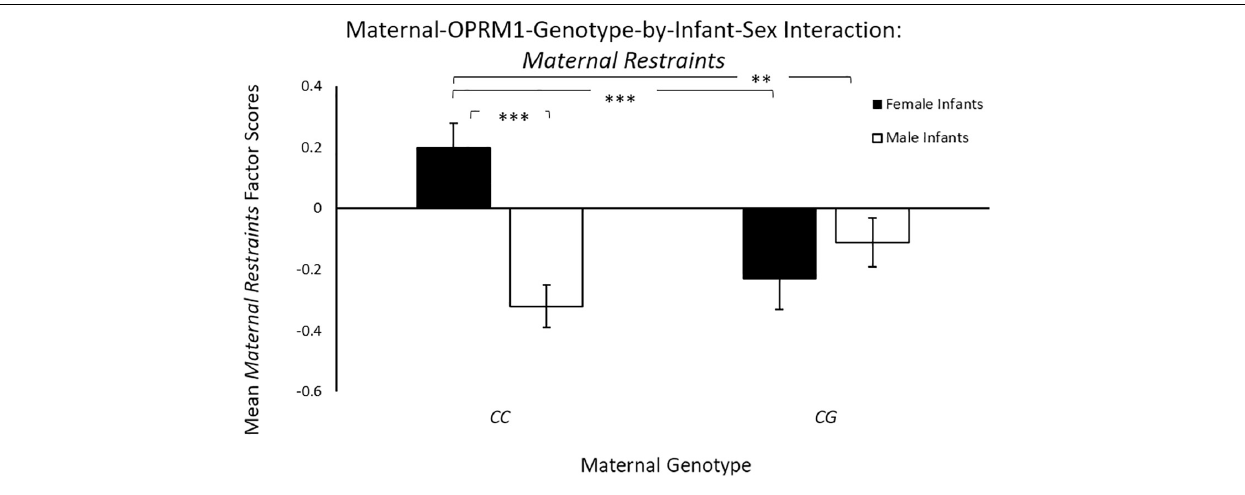
FIGURE 2 | Results showed a significant two-way sex-by-maternal-genotype interaction for Maternal Restraints (p = 0.001), with CC mothers with daughters exhibiting higher Maternal Restraint scores on average, when compared to CG genotype mothers with daughters (p < 0.001) or to CC mothers with sons ( p < 0.001). White bars represent mothers with male offspring, and black bars represent mothers with female offspring; * p < 0.05, ** p < 0.01, and *** p <